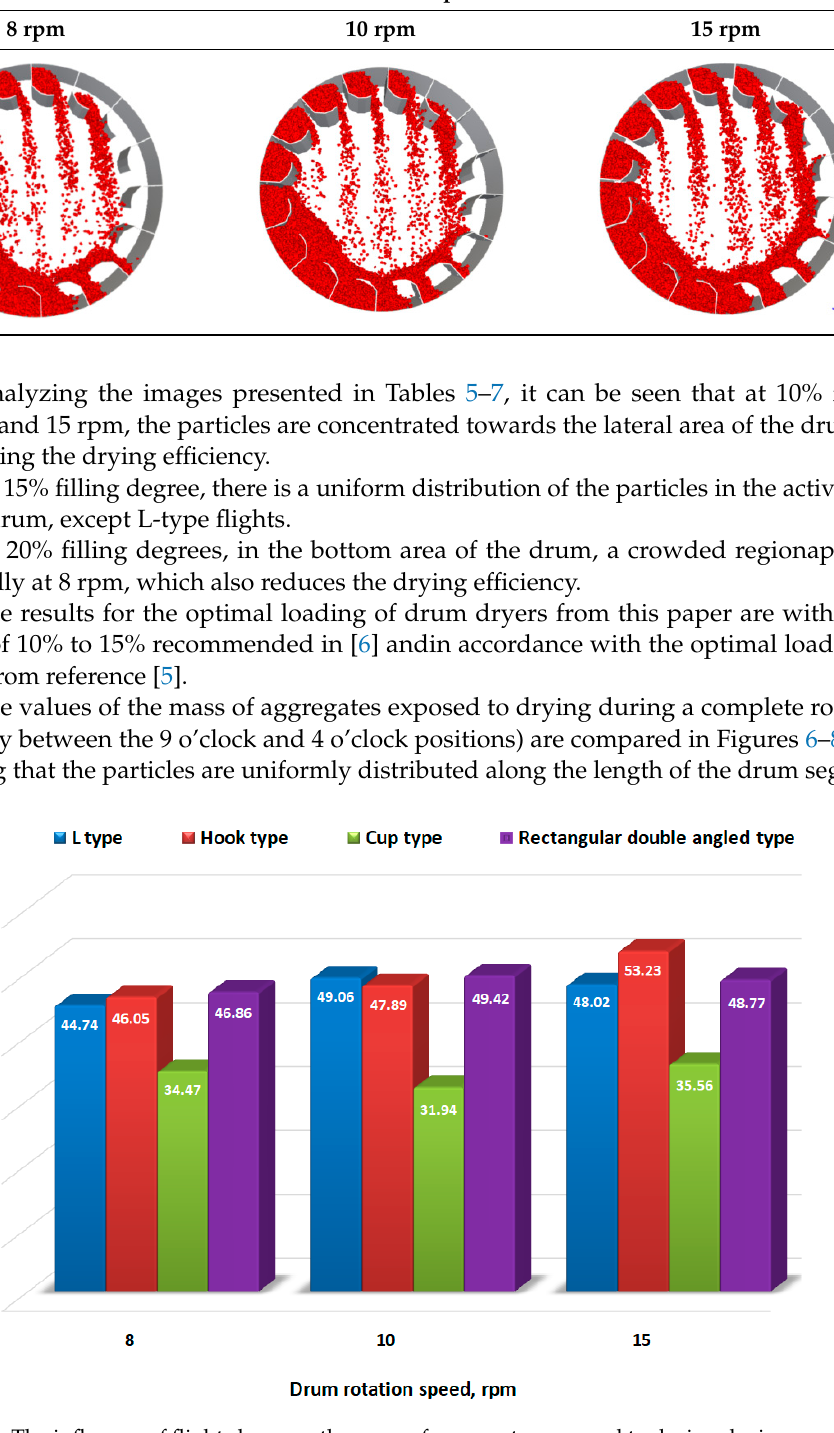
Figure 6. The influence of flight shape on the mass of aggregates exposed to drying during a complete rotation for 10% drum filling degree.